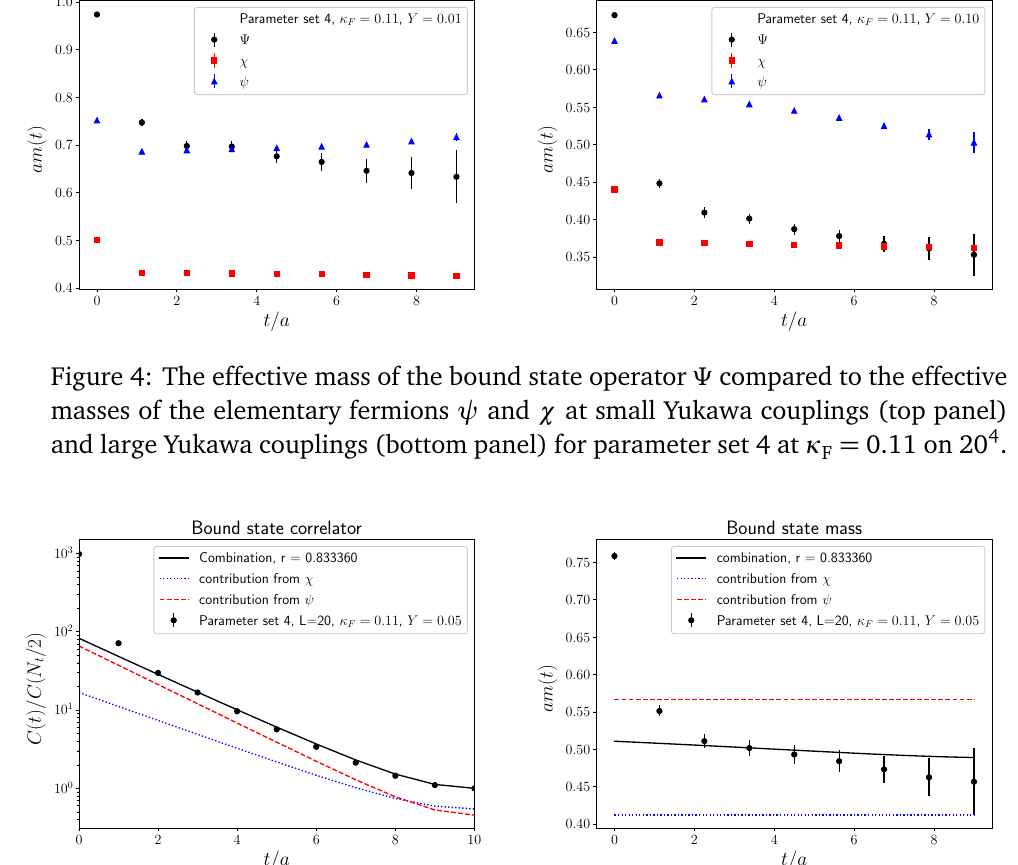
Figure 5: Example of the mixing effect for the bound state correlator (top panel) and the effective mass (bottom panel) for parameter set 4 on 20 4 at κ Y = 0.05, using the infinite-volume extrapolated masses from table